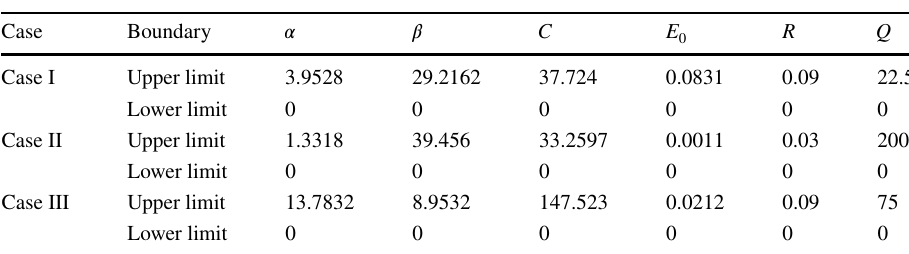
Table 7 The statistical results of